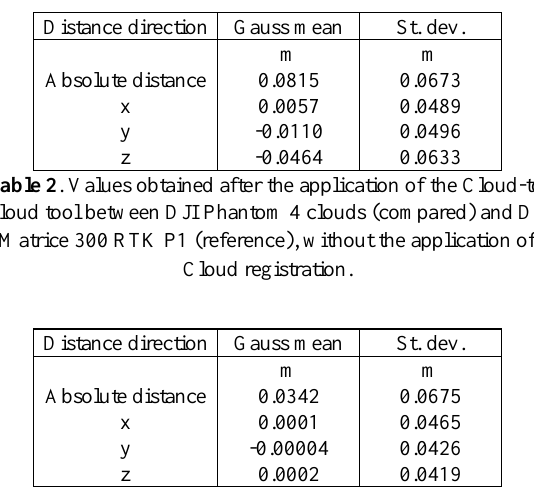
Table 3 . Values obtained after application of the Cloud-to- Cloud tool between DJI Phantom 4 clouds (compared) and DJI Matrice 300 RTK P1 (reference), after application of Cloud registration (shift and rotation with respect to X, Y, Z).